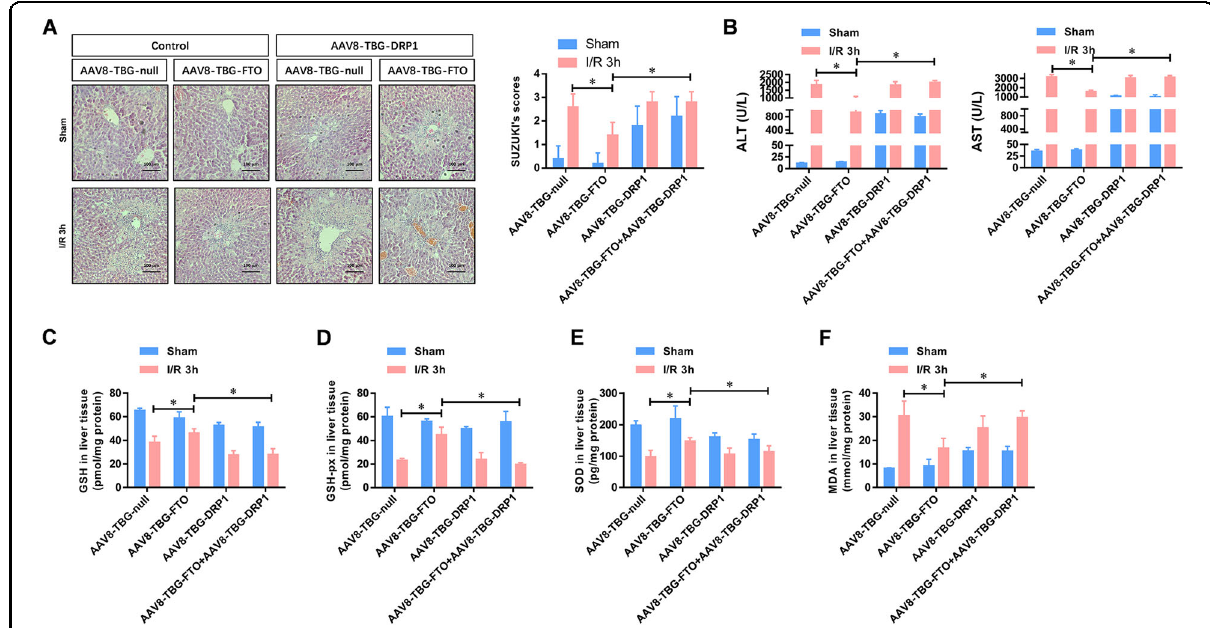
Fig. 7 Drp1 contributes to the protective effect of FTO against HIRI. A Representative histopathologic images of liver sections harvested at 24 h after reperfusion (H&E staining; scale bars, 100 μ m). The damage degree was graded using Suzuki criteria. B Blood samples were collected to determine the ALT and AST levels (U/L). C – F Tissue levels of GSH, GSH-Px, SOD, and MDA were detected using ELISA at indicated time points after reperfusion. N = 5; * P < 0.05 vs. indicated